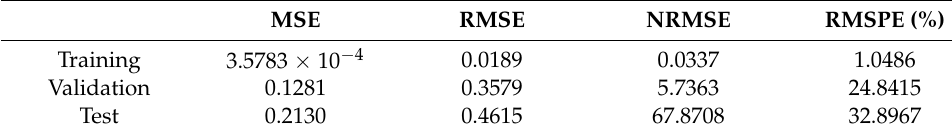
Table 3. Performance indices of the MLSLF algorithm.